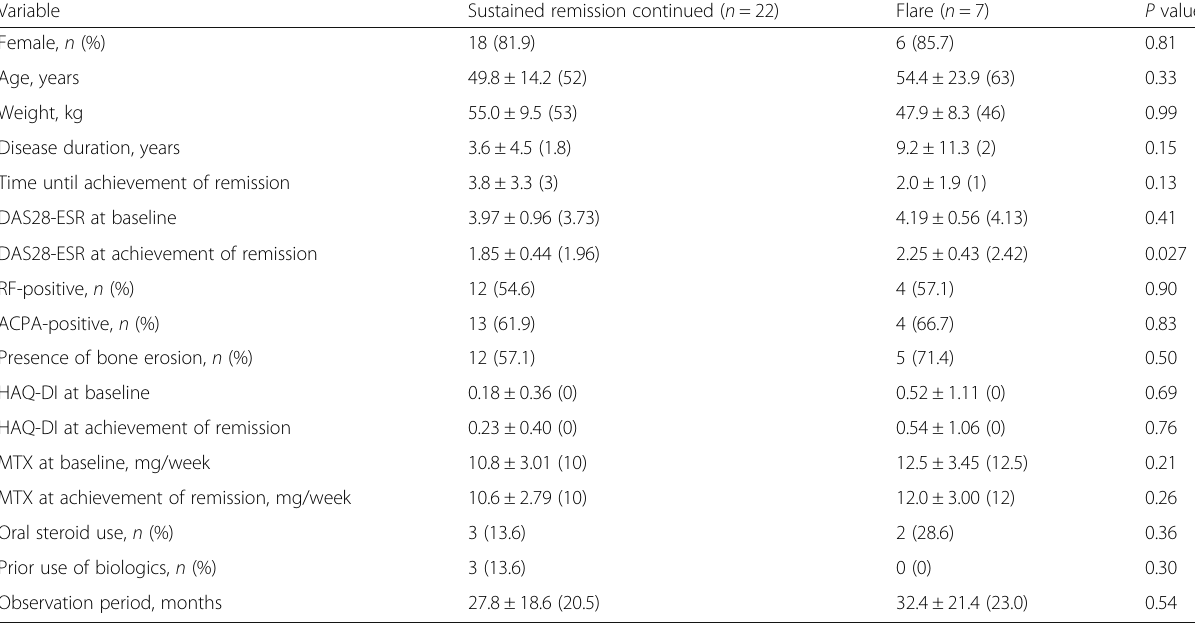
Table 4 Factors associated with the continuation of sustained remission Variable